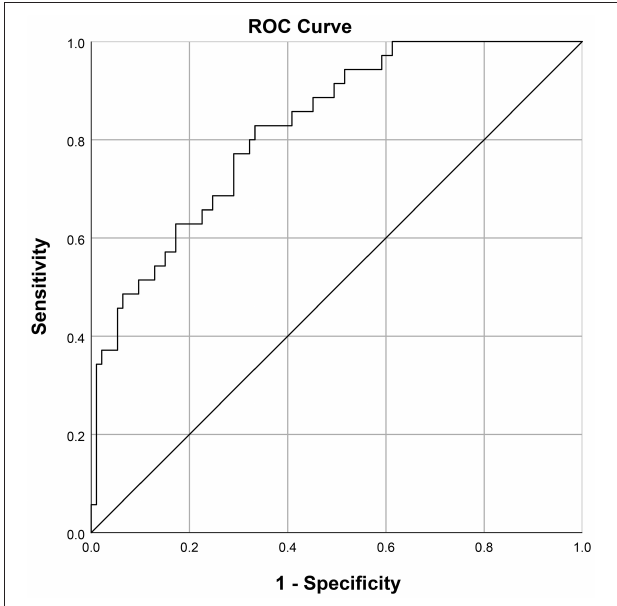
FIGURE 3 | Receiver operating characteristic curve for the prediction model: Area under the curve was 0.824 (95% confidence interval 0.748–0.900).